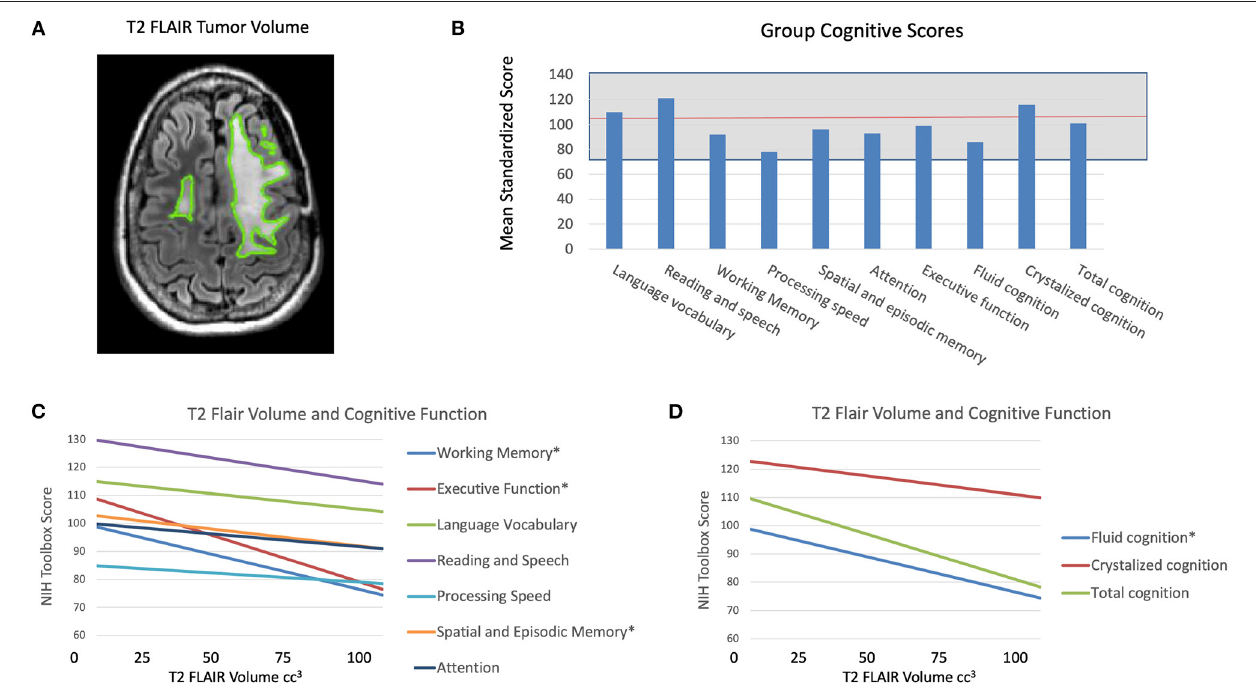
FIGURE 1 | (A) Example of tumor volume defined by hyperintensity on T2 FLAIR MR images. (B) Mean age-corrected cognition scores from the NIH Toolbox, which has a healthy control mean of 100 and standard deviation of 10 (indicated by the gray box). (C) Mean age-corrected cognition subscores from the NIH Toolbox by T2 FLAIR tumor volume at the time of cognitive testing, * p < 0.05, corrected for multiple comparisons. (D) Mean age-corrected cognition summary scores from the NIH Toolbox by T2 FLAIR tumor volume at the time of cognitive testing, * p < 0.05, corrected for multiple